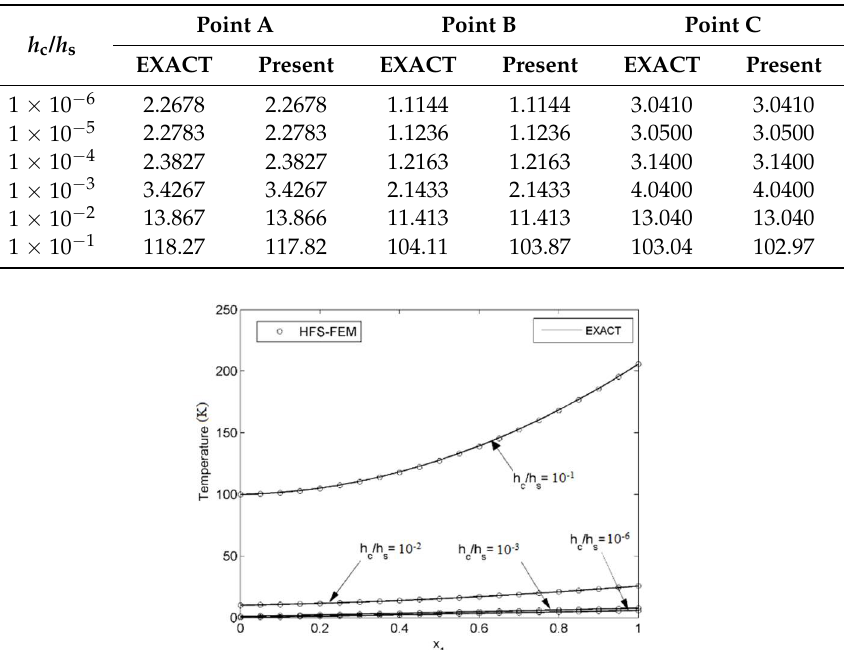
Figure 6. Variation of temperature along the interface for η = 10 in the second test. Table 3. Temperature results at the three specific points for different thickness ratios for η = 1000 h c / h s in the second test.